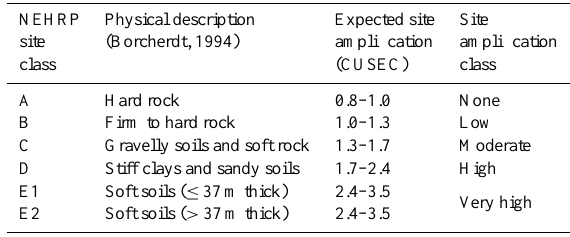
Table 1. Amplifier classification